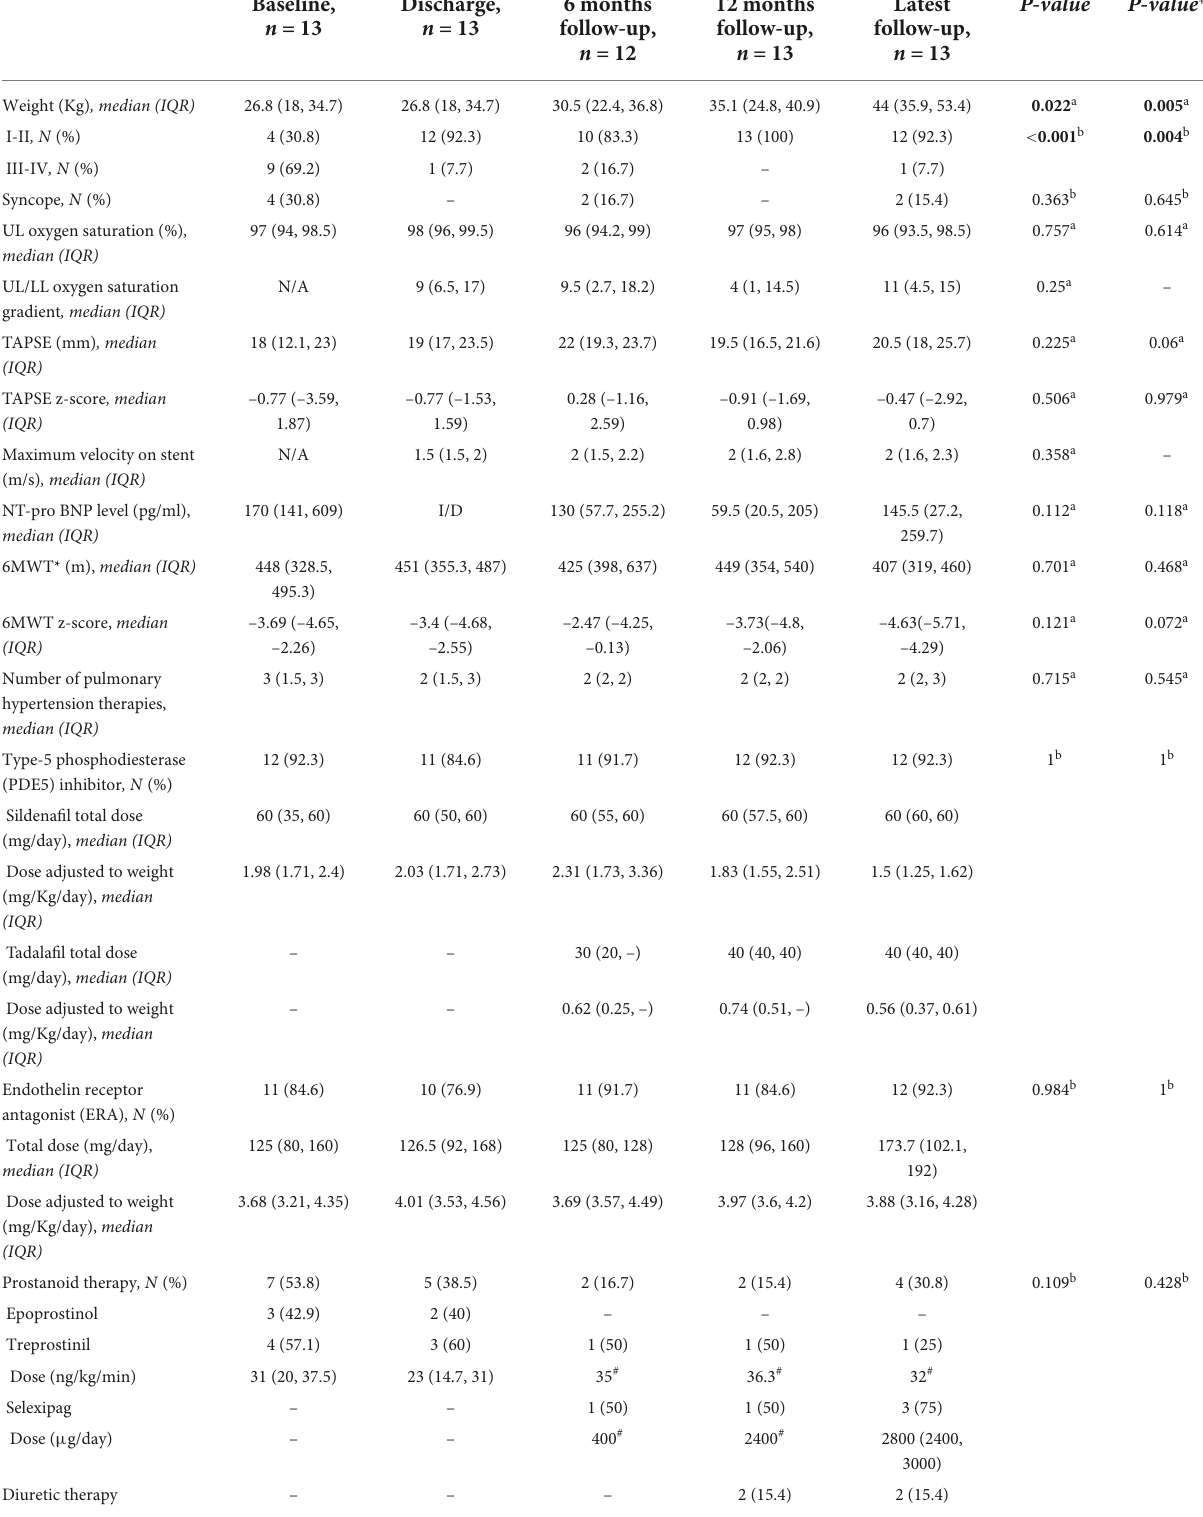
TABLE 2 Detailed comparison of clinical, echocardiographic, biological, and pharmacological parameters across